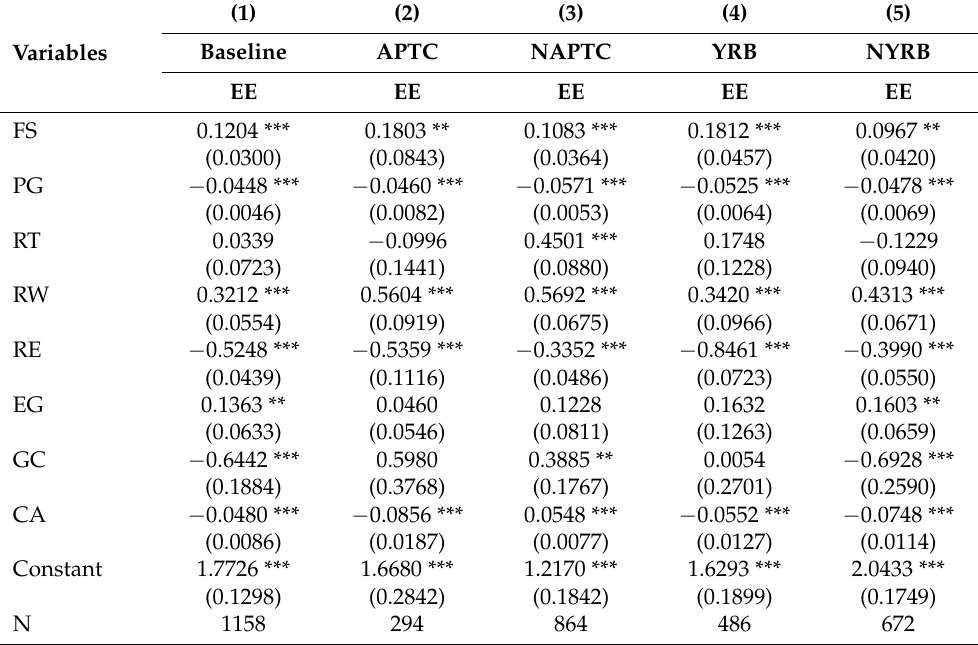
Table 7. Empirical analysis of environmental regulation heterogeneity